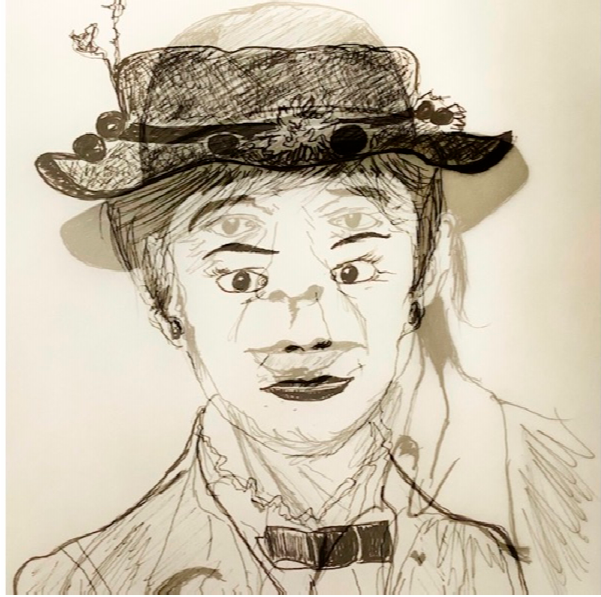
Figure 1. Deleuze becoming Poppins transformation: Embodied symbiosis on a molecular level. (All images are original and drawn by Donna Carlyle).